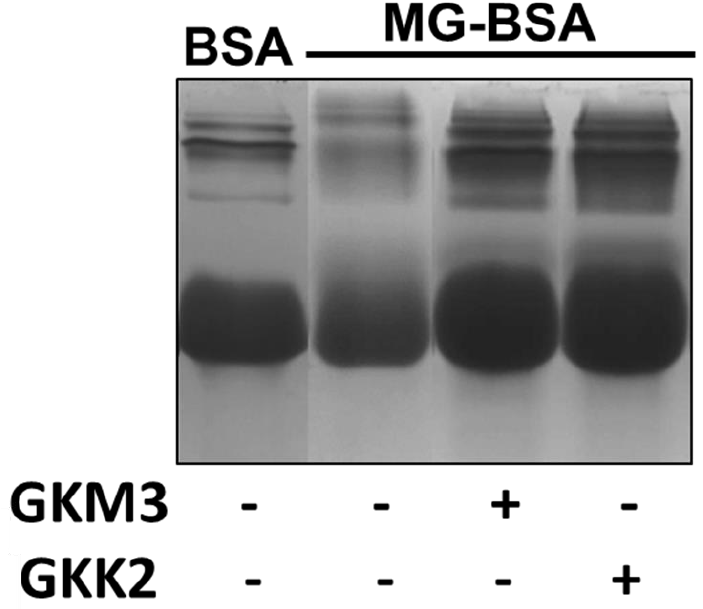
Figure 2. Effect of GKM3 and GKK2 on the SDS-PAGE results of products in the final stage of pro- tein glycation. SDS-PAGE: sodium dodecyl sulfate polyacrylamide gel electrophoresis. The 3-D fluorescent intensity described the late stage of the protein glycation (Figure 3).